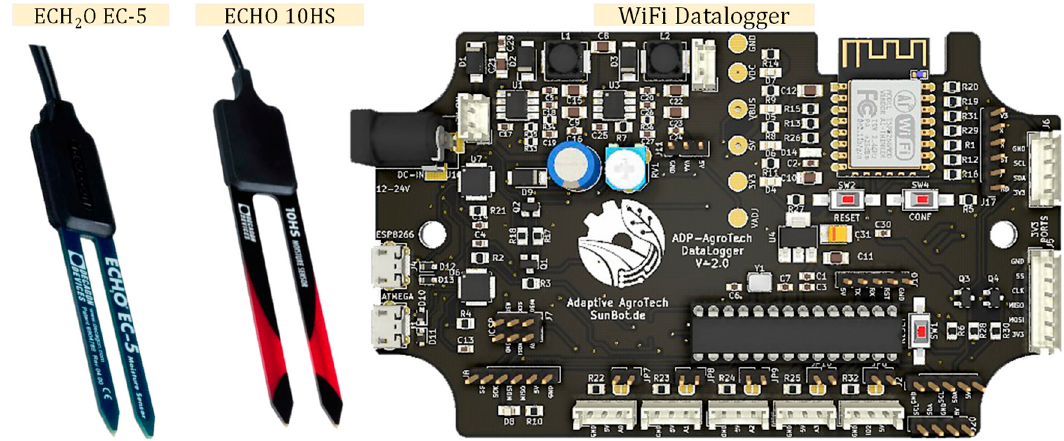
Figure 1. Internet of Things (IoT) monitoring of soil moisture data using two capacitive soil moisture probes interfaced with a WiFi datalogger that has been custom-built to withstand harsh field conditions. Table 1. Soil moisture sensing technology methods.